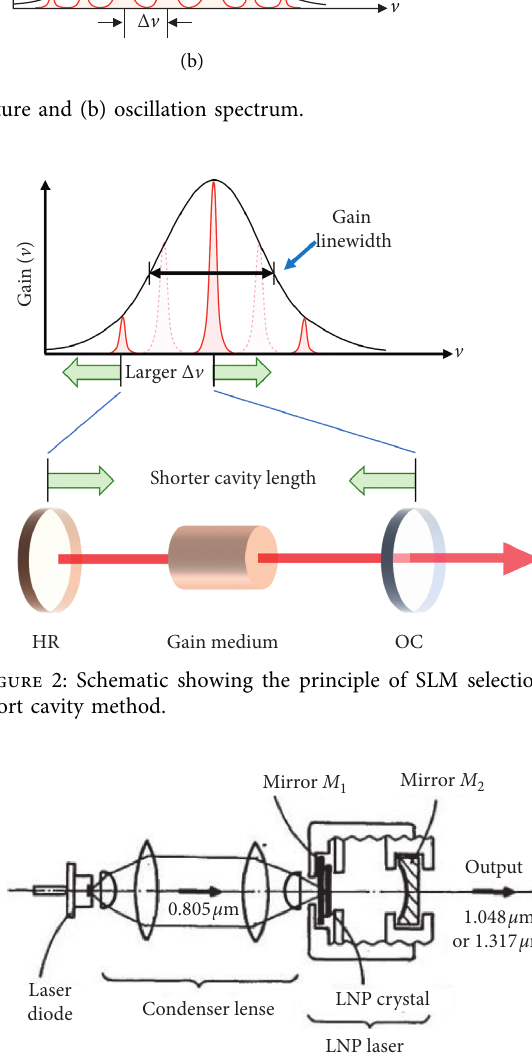
4 O 12 lasers for SLM